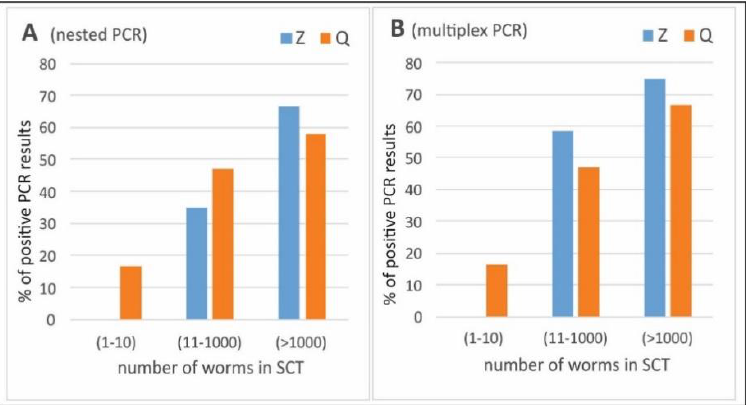
Figure 1. Percentages of Echinococcus multilocularis positive PCR results in samples of feces coming from intestines with different number of worms estimated with sedimentation and counting technique (SCT)—grouped in three levels of intensity: low (1–10 worms), medium (11–1000) and high (>1000) intensity. Z—ZR Fecal DNA Mini Prep (Zymo Research, Freiburg, Germany); Q—QIAamp FAST DNA